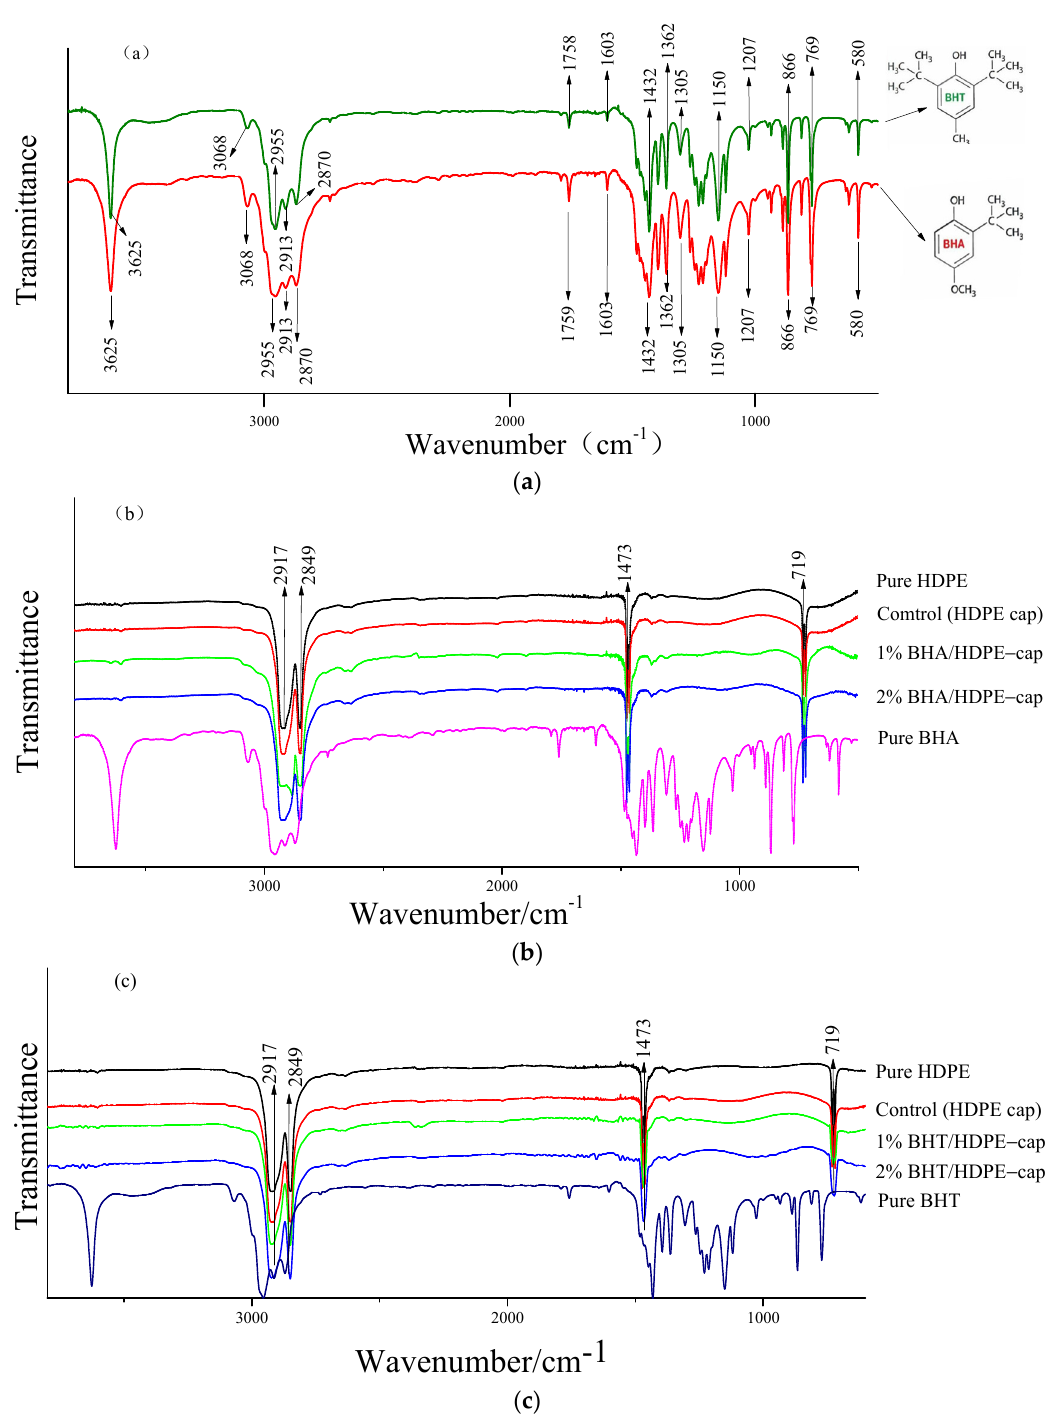
Figure 4. Fourier-transform infrared (FT-IR) spectra of pure antioxidants ( a ) and composite caps containing BHA ( b ) and BHT ( c